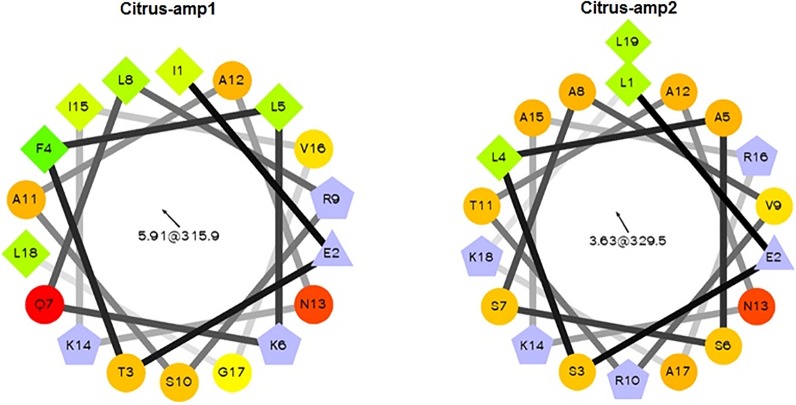
Helical wheel projections of AMP (Hydrophilic residues as circles, hydrophobic residues as diamonds, and potentially positively charged as pentagons).Hydrophobicity degree: the most hydrophobic residue is green and low hydrophobicity is coded as yellow. Hydrophilic residues are coded red with pure red being the most hydrophilic (uncharged) residue, and the degree of red color represent the level of hydrophilicity. Light blue represents charged residues.